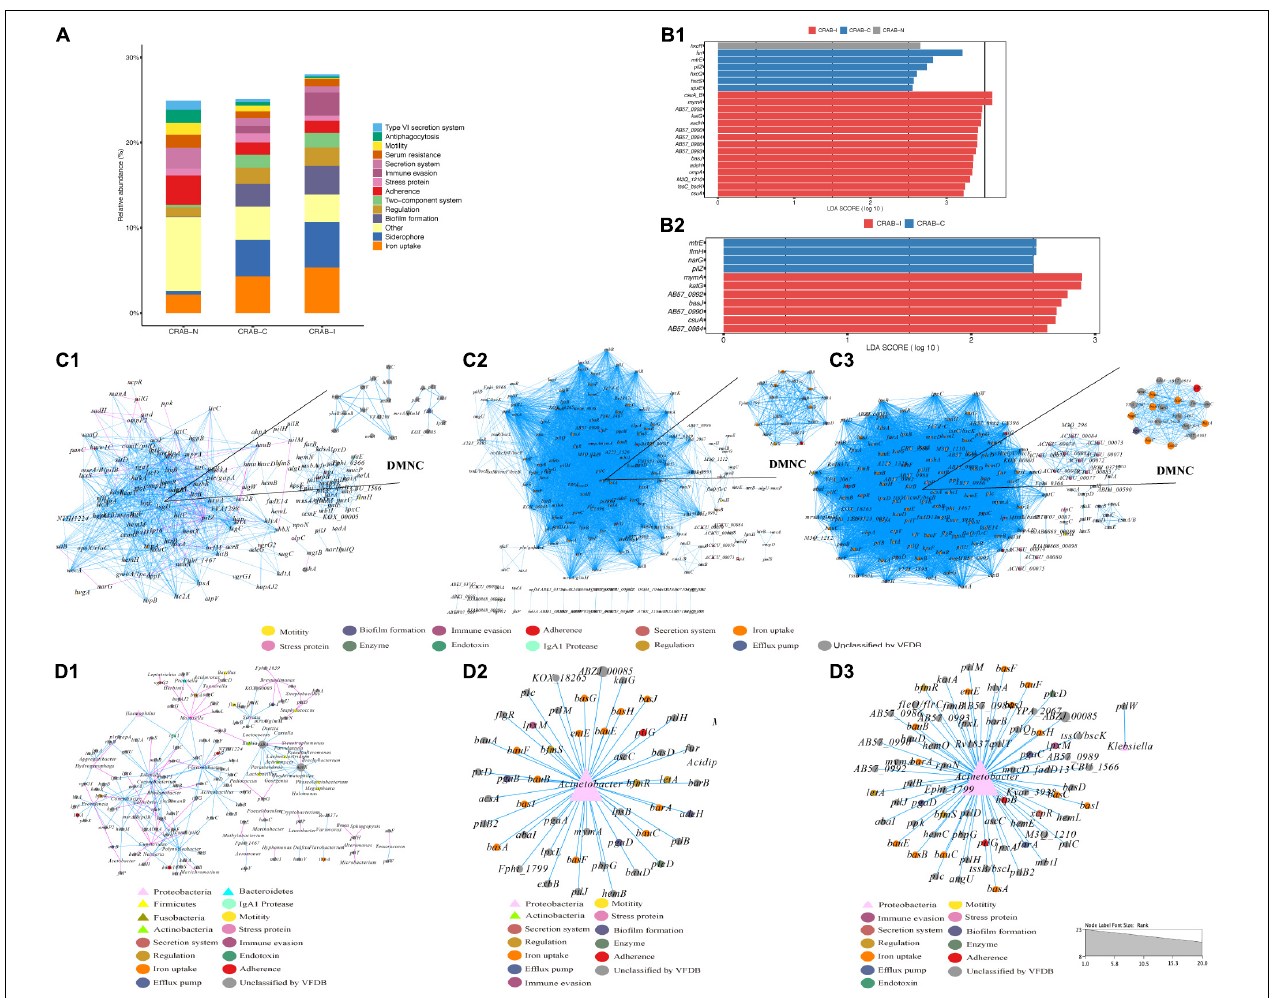
FIGURE 6 | Comparison of virulence factors and Network analysis. (A) Summary of the top 10 relative abundances of function group of virulence genomes in each group; (B) LEfSe and LDA scores indicated significant differences in the virulence genes among groups. (B1) Represented differences among the CRAB-N, CRAB-C, and CRAB-I patients; (B2) Represented differences between the CRAB-C and CRAB-I patients. (C) Co-occurring network of virulence genomes communities in LRT samples from three patient groups ( C1 : CRAB-N, C2 : CRAB-C, C3 : CRAB-I). The nodes are colored by the function of virulence genomes, the upper right corner shows DMNC; (D) Co-occurring network of virulence genomes and microbiota communities in LRT samples from three patient groups based on correlation analysis ( D1 : CRAB-N, D2 : CRAB-C, D3 : CRAB-I). The nodes are shaped by virulence genomes and bacteria, sized by the relative abundances and colored by the function of virulence genomes or phylum. The connections in the network represent a strong ( r > 0.8) and significant ( q < 0.05) correlations. The size of each node is proportional to the number of connections. Light blue lines represent positive correlations, and red lines represent negative